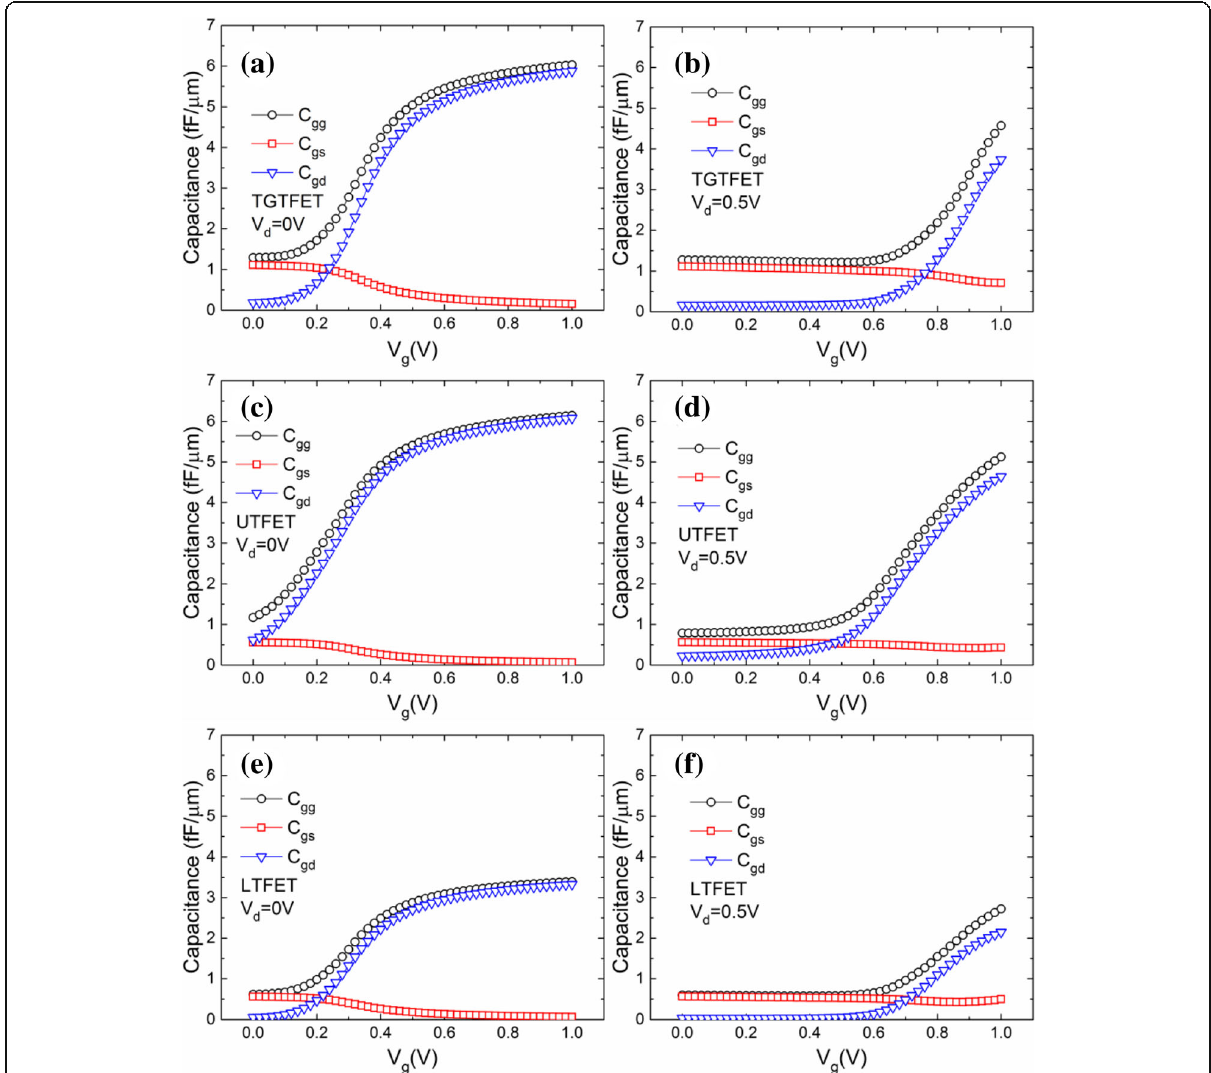
Fig. 14 Capacitance of TGTFET versus V g under a V d = 0 V and b V d = 0.5 V. Capacitance of UTFET versus V g under c V d = 0 V and d V d = 0.5 V. Capacitance of LTFET versus V g under e V d = 0 V and f V d = 0.5